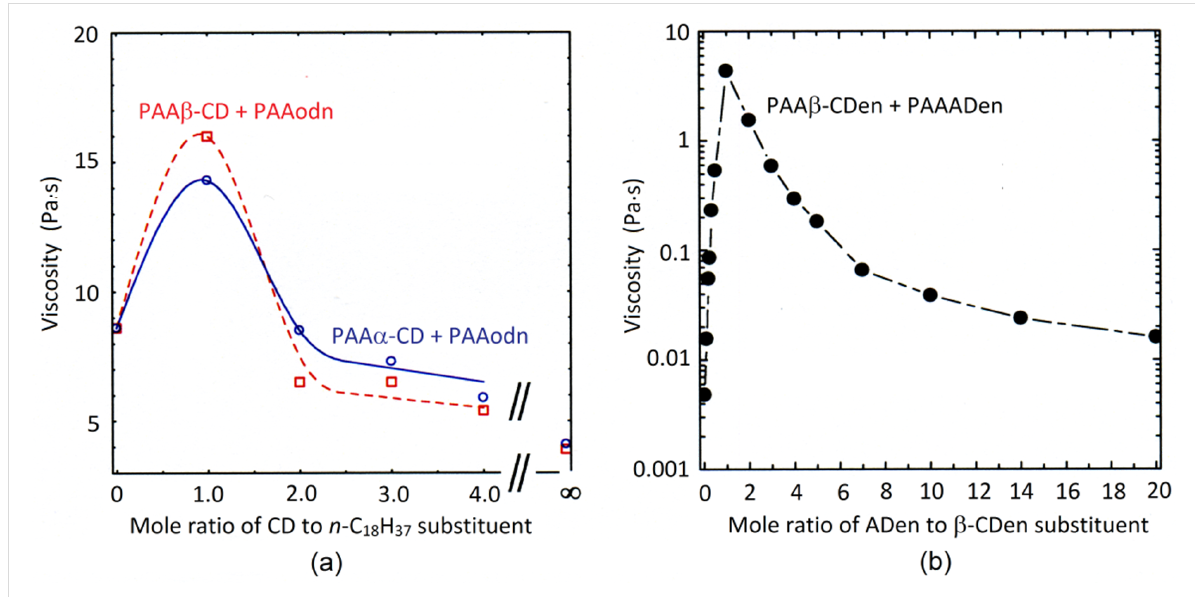
Figure 7: Variation of viscosity with mole ratio of CD substituents to hydrophobic substituents on poly(acrylate), PAA. (a) 0.5 wt % aqueous solutions of, respectively, 2.5 and 2.1% α -CD and β -CD randomly substituted PAA (PAA α -CD and PAA β -CD) and n -C 18 H 37 3% randomly substituted PAA (PAAodn) [44]. Adapted with permission from [44]. Copyright (2005) American Chemical Society. (b) 2.0 wt % aqueous solution of 2.9% β -CDen randomly substituted PAA (PAA β -CDen) and 3.0% ADen randomly substituted PAA (PAAADen) [57]. Adapted with permission from [57]. Copyright (2008) American Chemical